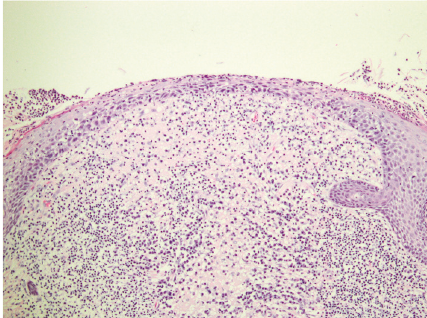
Figure 4: Neutrophils infiltrate the superficial layers of the epider- mis. The dermis showed a mixed chronic inflammatory response and some dermal